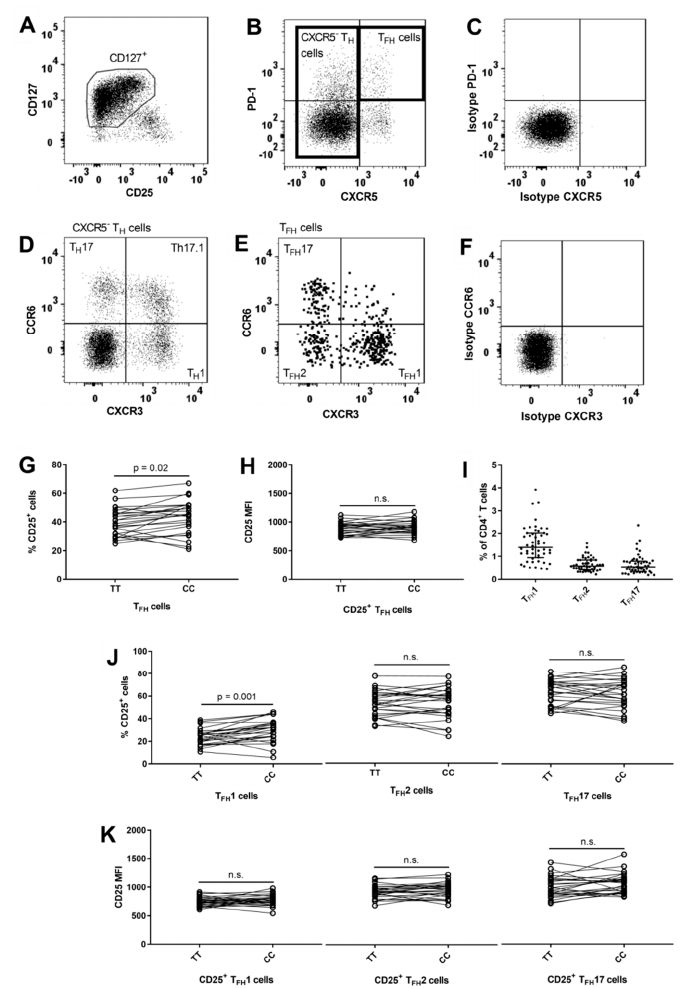
Figure 4. IL2RA genotype associations on CD4 + T follicular helper subsets. ( A ) Gating of CD127 + cells